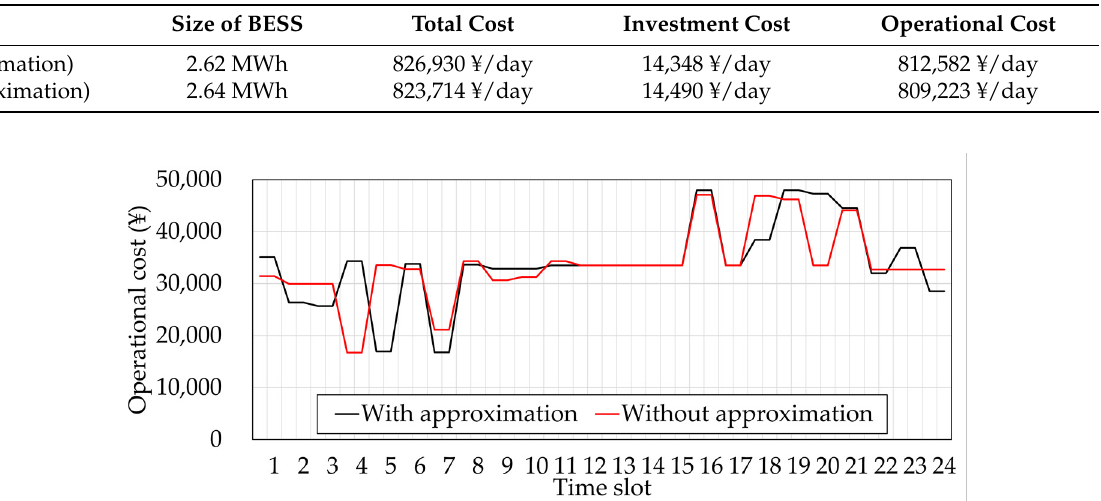
Figure 9. Comparison of operational costs in Cases 1 and 4. BESS size in each case is 2.62 MWh in Case 1 and 2.64 MWh in Case